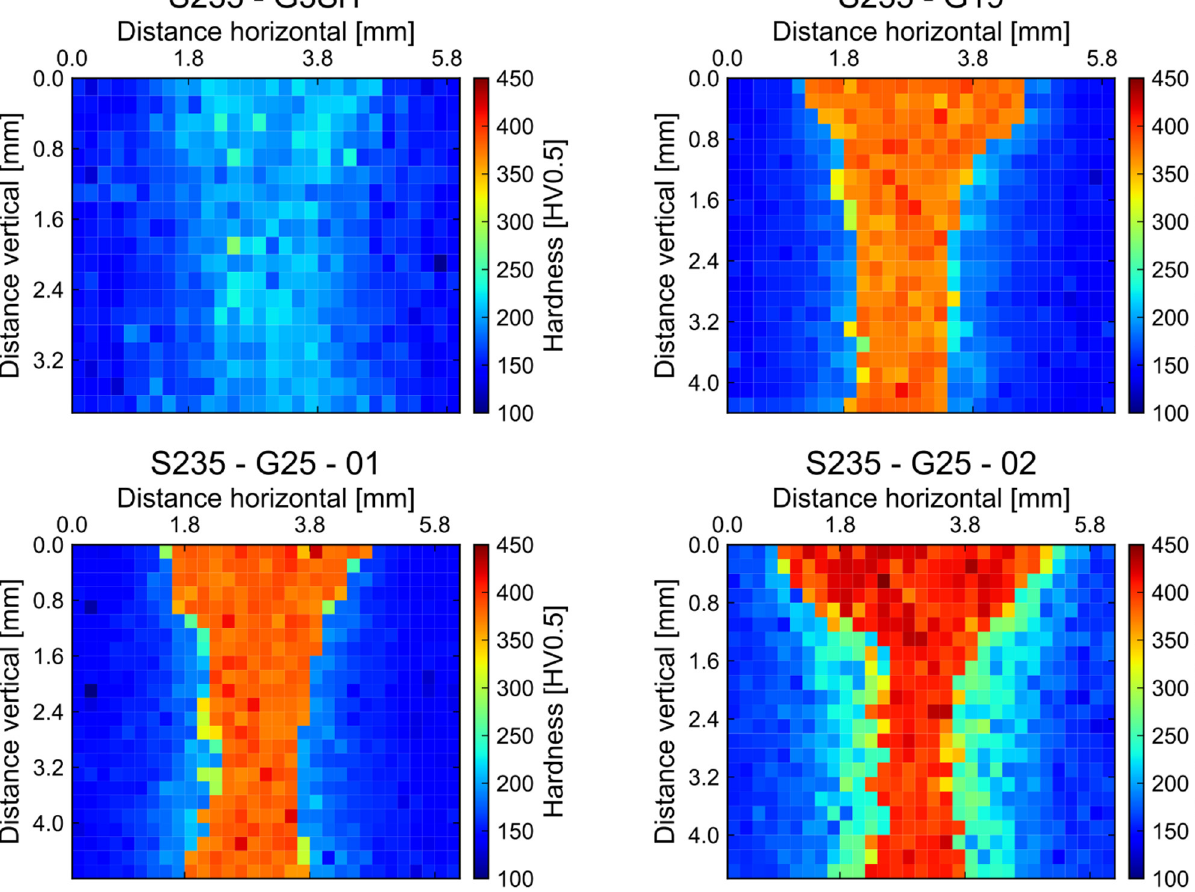
Figure 5. Hardness mapping of S235-G3Si1 (similar weld) showing a homogeneous hardness distribution and a slight increase in the weld seam. All dissimilar welds ( S235-G19 , S235-G25-01 , S235-G25-02 ) have higher hardness values compared to the base material, while no sharp variation in hardness values can be seen within the welds.